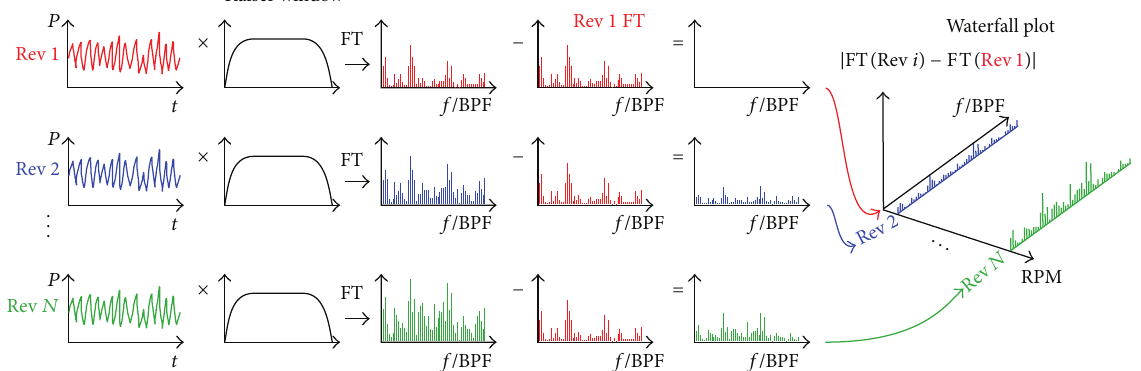
Figure 9: Data processing strategy for generating waterfall